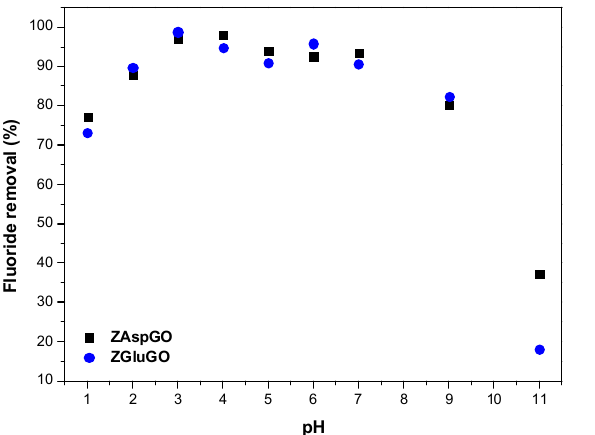
Figure 7. Effect of pH on the adsorption of fluoride ion by the ZAAGOs at 10 mg/L initial concen- tration.